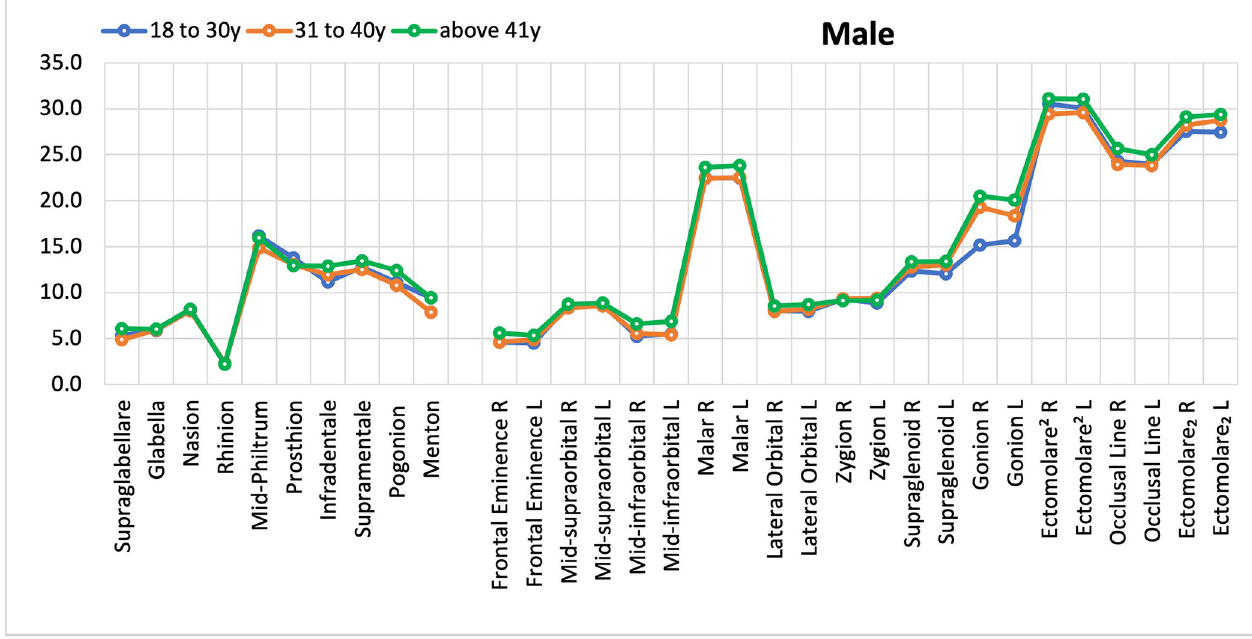
PLOS ONE | https://doi.org/10.1371/journal.pone.0270980 July 15,